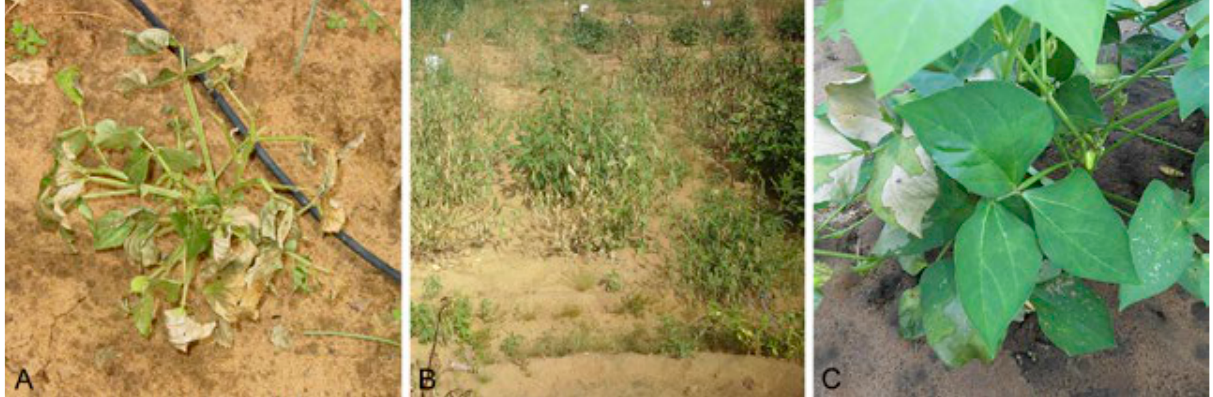
Figure 1. Disease symptoms of Macrophomina (charcoal rot) in infested fields. A. Advanced level of infestation on cowpea ( Vigna unguiculata ) in an experimental field with a drip irrigation system (Agrhymet, Niger). B. Charcoal rot symptoms in a sorrel ( Hibiscus sabdarifa ) field during the rainy season (Agrhymet, Niger). C. Early infection in a young cowpea ( Vigna unguiculata ) plant, in an experimental field during the rainy season (Bambey,